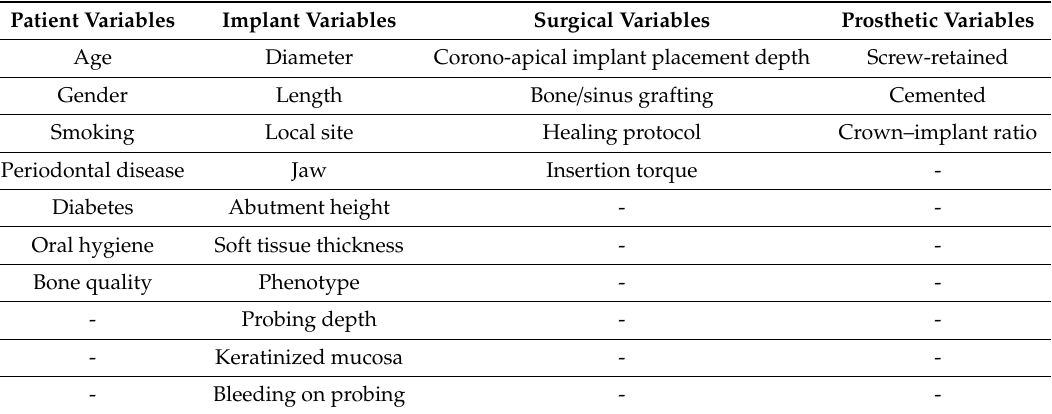
Table 1. Variables recorded in this study.